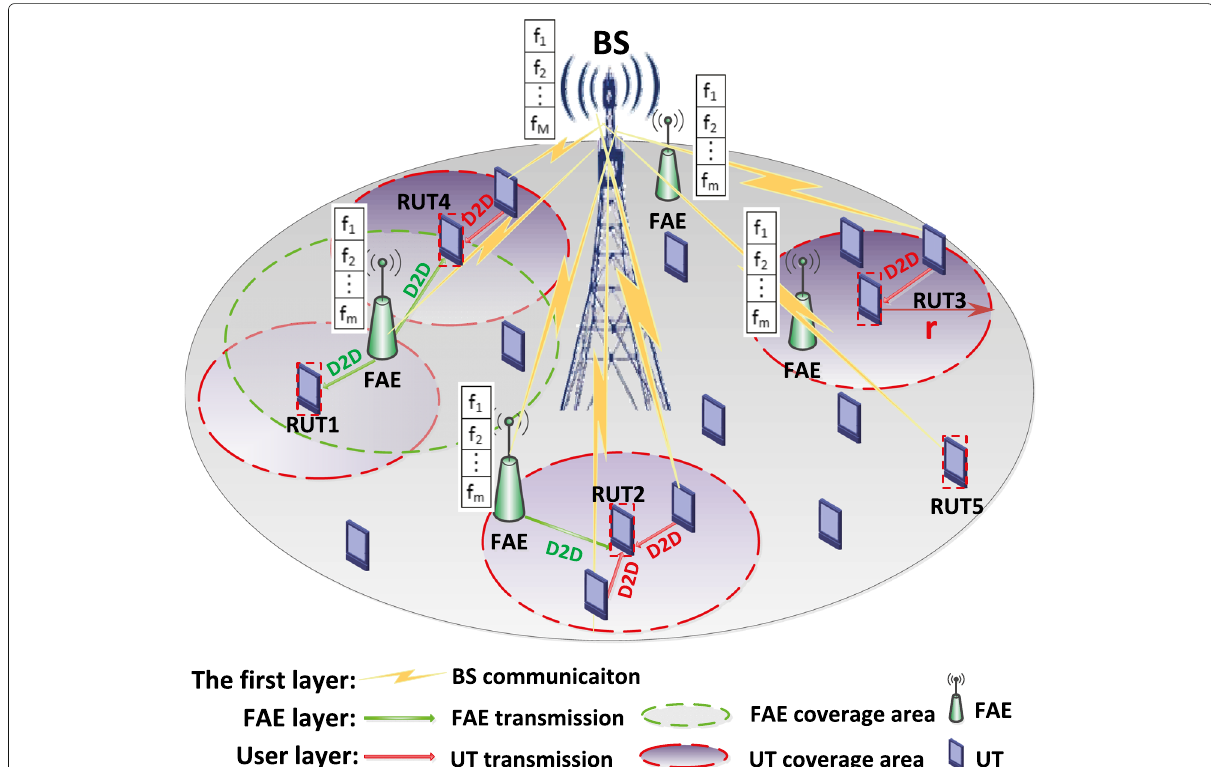
Fig. 2 The architecture of three-tier heterogeneous network equipped with FAEs in a single macro-cell. This figure describes the proposed three-tier heterogeneous architecture for content delivery in cellular networks, which includes BS, femtocaching auxiliary equipments (FAEs), and multiple